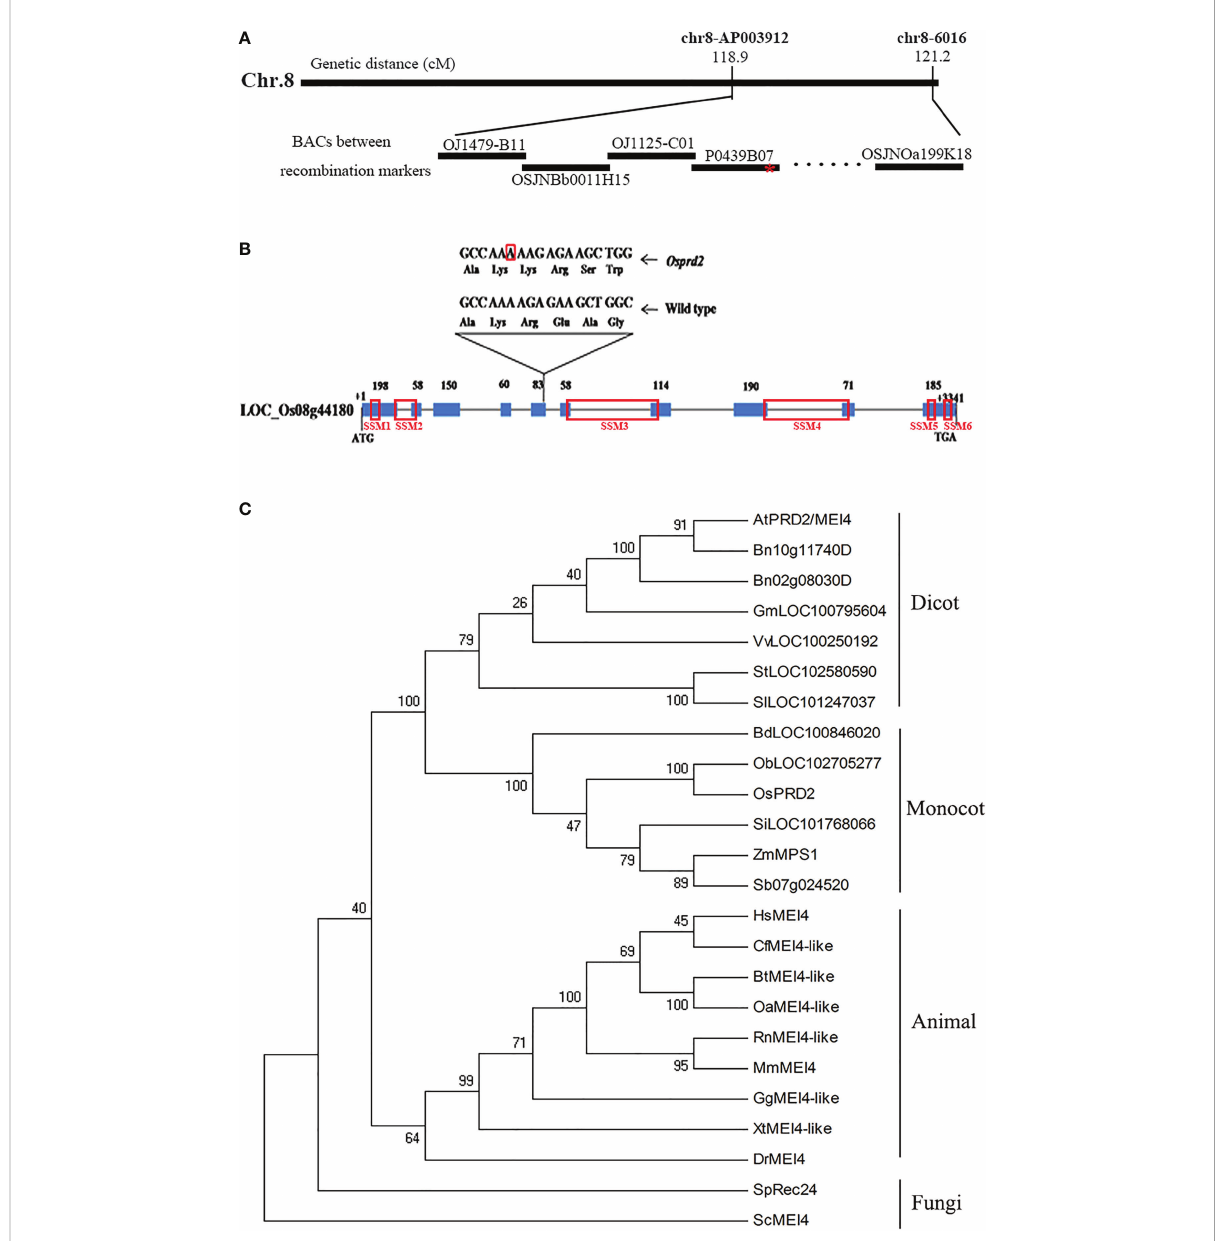
FIGURE 1 Map-based cloning of OsPRD2 and phylogenetic analysis of proteins homologous to OsPRD2. (A) Map-based cloning of OsPRD2 gene, red star indicated the mutation site; (B) gene structure and the mutated sites of OsPRD2 , the nucleic acid with red box indicated A insertion in osprd2 mutant, red box on the gene indicated the conserved SSMs motif of PRD2/MEI4 family members; (C) neighbor-joining tree of proteins homologous to OsPRD2. The tree was constructed from the alignment of full-length proteins in rice and other species. The unannotated sequences accession numbers are given in the brackets after species